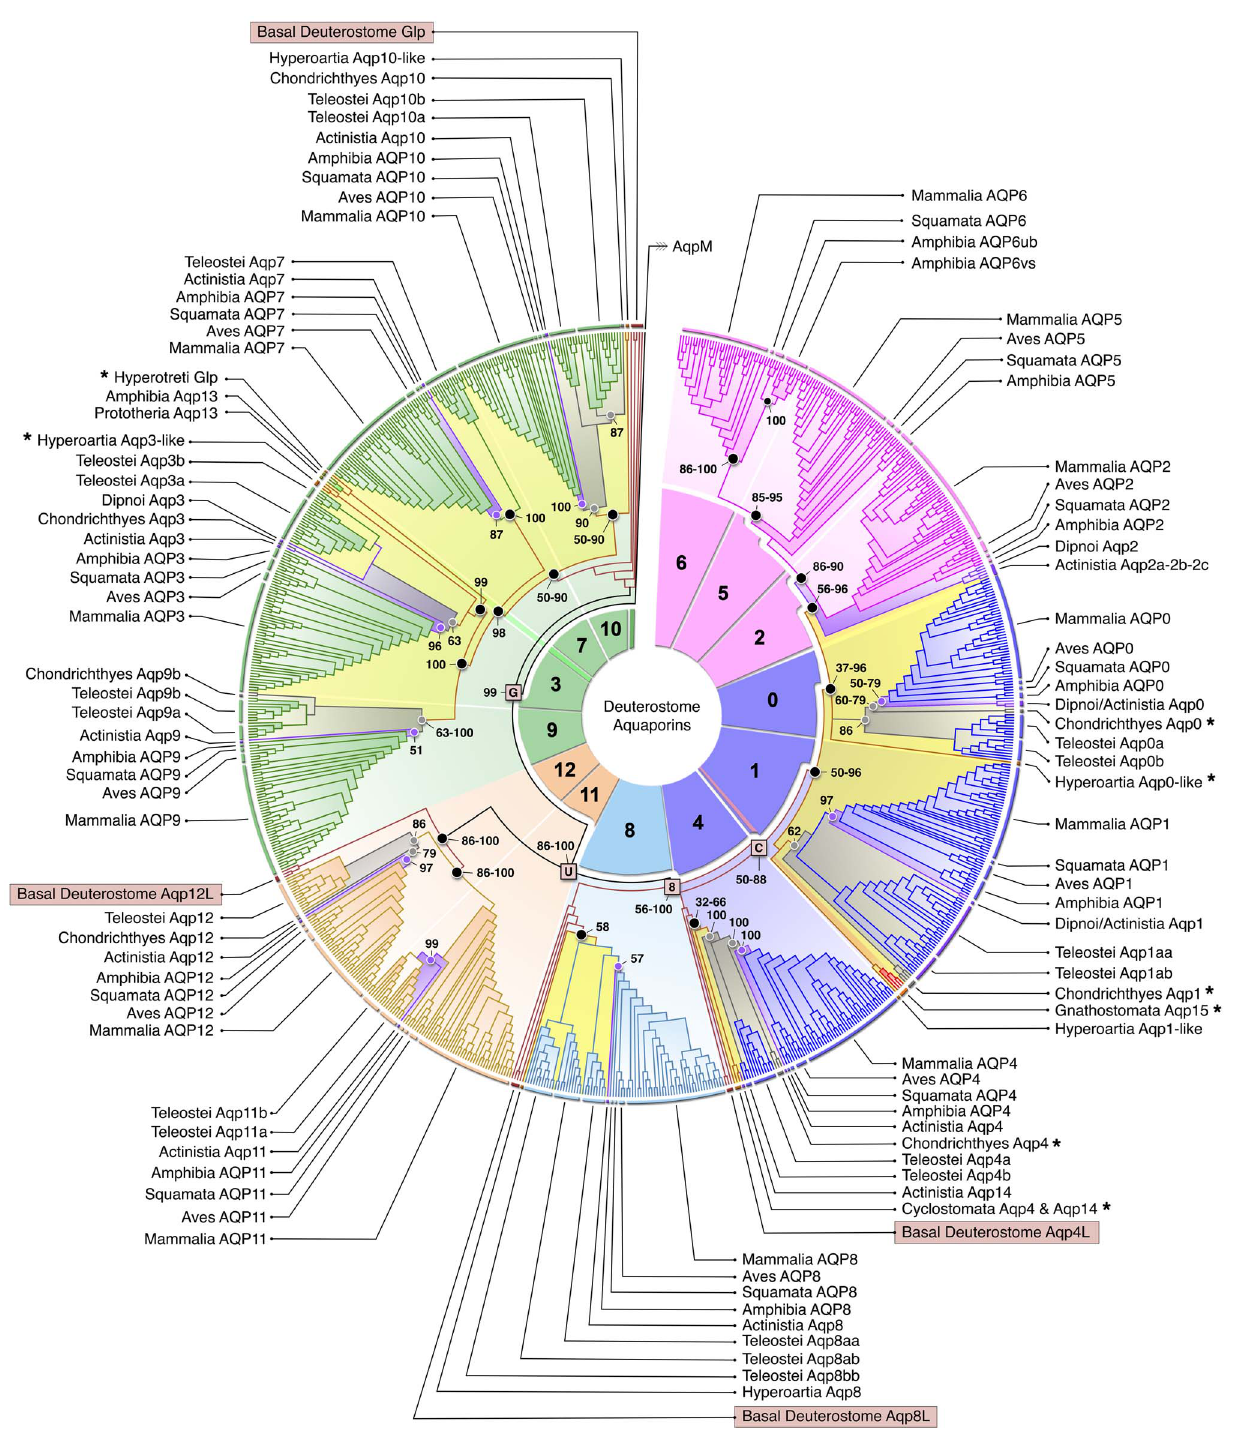
Figure 1. Preliminary Molecular Phylogeny of the Deuterostome Aquaporin Superfamily. The Bayesian majority rule consensus tree of the codon alignment is rooted with aqpM . The aquaporin subfamilies annotated in the central coil are separated into four major grades: aquaglyceroporins (G), unorthodox aquaporins (U), aquaporin 8-type (8) and classical aquaporins (C). Posterior probabilities are shown at selected nodes. * indicates sequencing of taxon. Evolutionary older nodes associated with Cyclostomata, Chondrichthyes and Actinisia are respectively shaded in yellow, grey and magenta. Teleost and tetrapod subclusters are shaded according to the aquaporin grade, except for sarcopterygian Aqp2, -5, and -6 paralogs, which are shaded in pink.